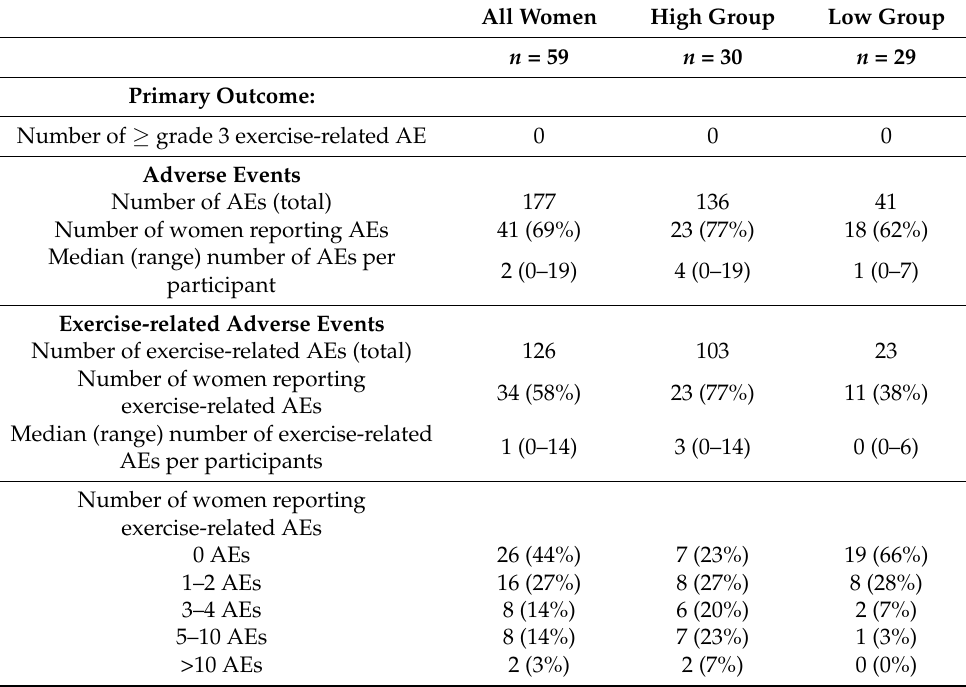
Table 4. Safety of exercise: Adverse events during the SAFE intervention. All Women High Group Primary